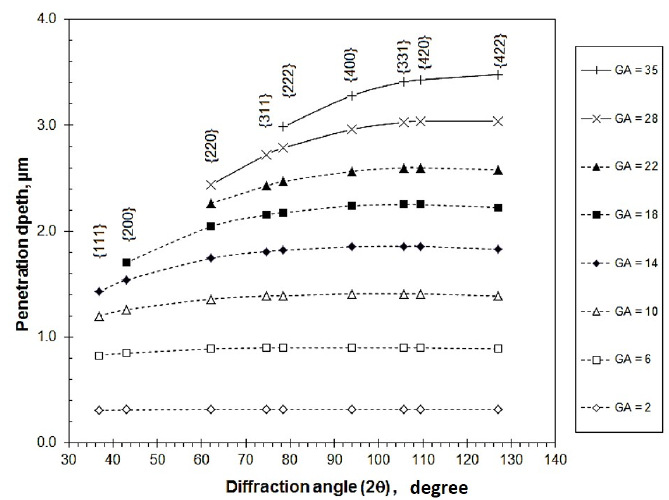
Figure 11. Effective penetration depths as a function of the applied incident Ω angle and the selected diffraction 2 θ angle.